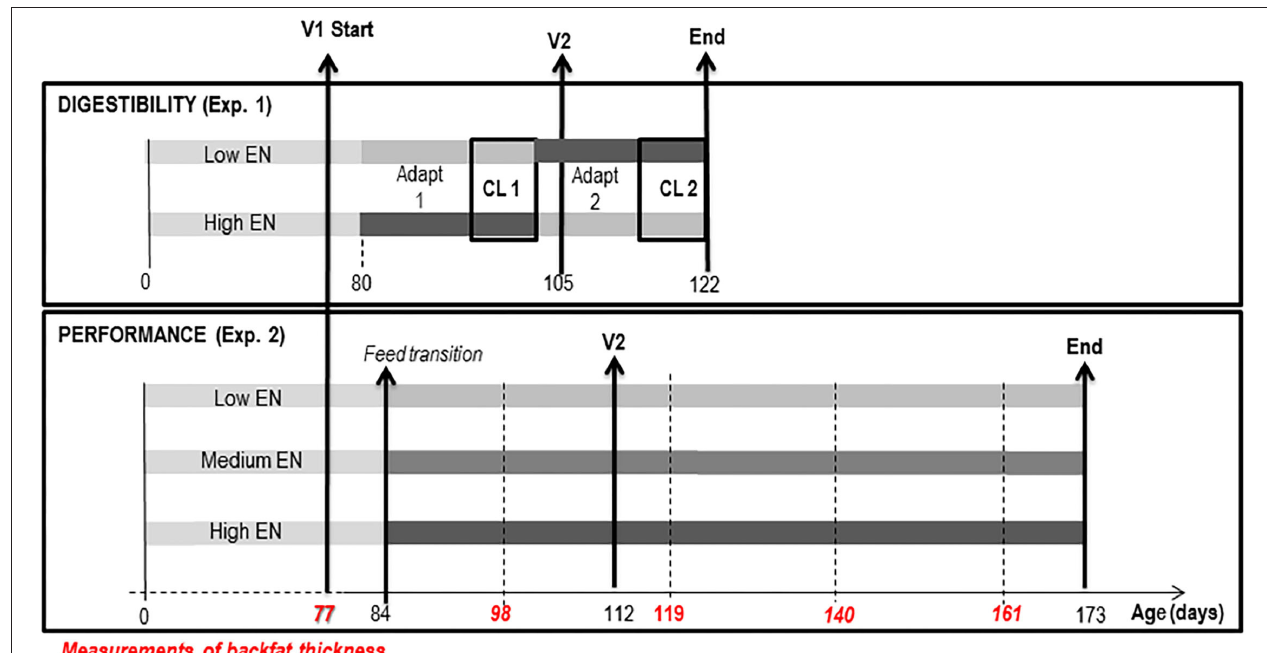
FIGURE 1 | Experimental design of Experiments 1 and 2. Digestibility and nitrogen balance (Exp. 1) was performed in 2 consecutive periods, composed of adaptation (Adapt 1 and 2) and collection period (CL 1 and CL 2), on each of the 4 pigs fed the 2 extreme diets in order to calculate the net energy (NE) content of the 3 diets. Net energy content of the Medium NE diet was calculated as the average of the NE content of Low NE and High NE diets. The performance experiment (Exp. 2) included 45 immunocastrated pigs (immunocastrated at the age of 77 and 112 days and slaughtered at the age of 172 days), divided into 3 experimental groups, each receiving one of the diets with low (Low NE), medium (Medium NE), or high (High NE) net energy (NE)